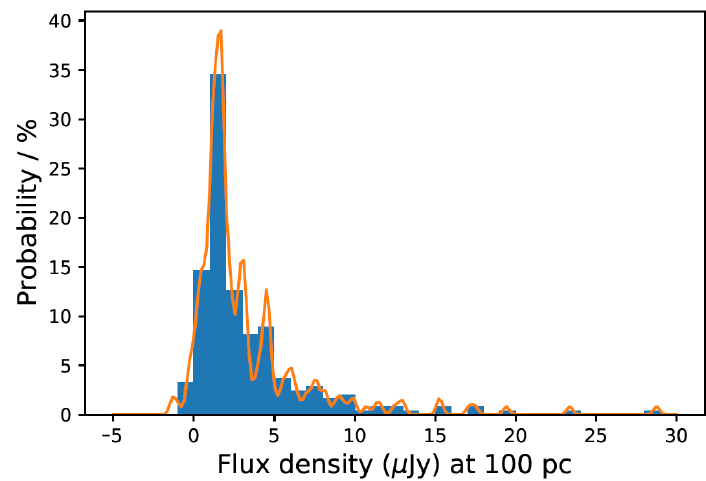
Figure 3. Flux density distribution of the burst sample. The histogram shows the probability density distribution of the 10-minute flux density at 1 pc at 2.8–4 GHz, from the results of Villadsen and Hallinan [61]. The probability density function generated for the data is shown as the curve.